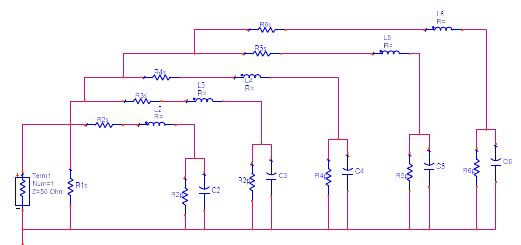
Figure 13: S11 original and fitted phase for patch without CRR.